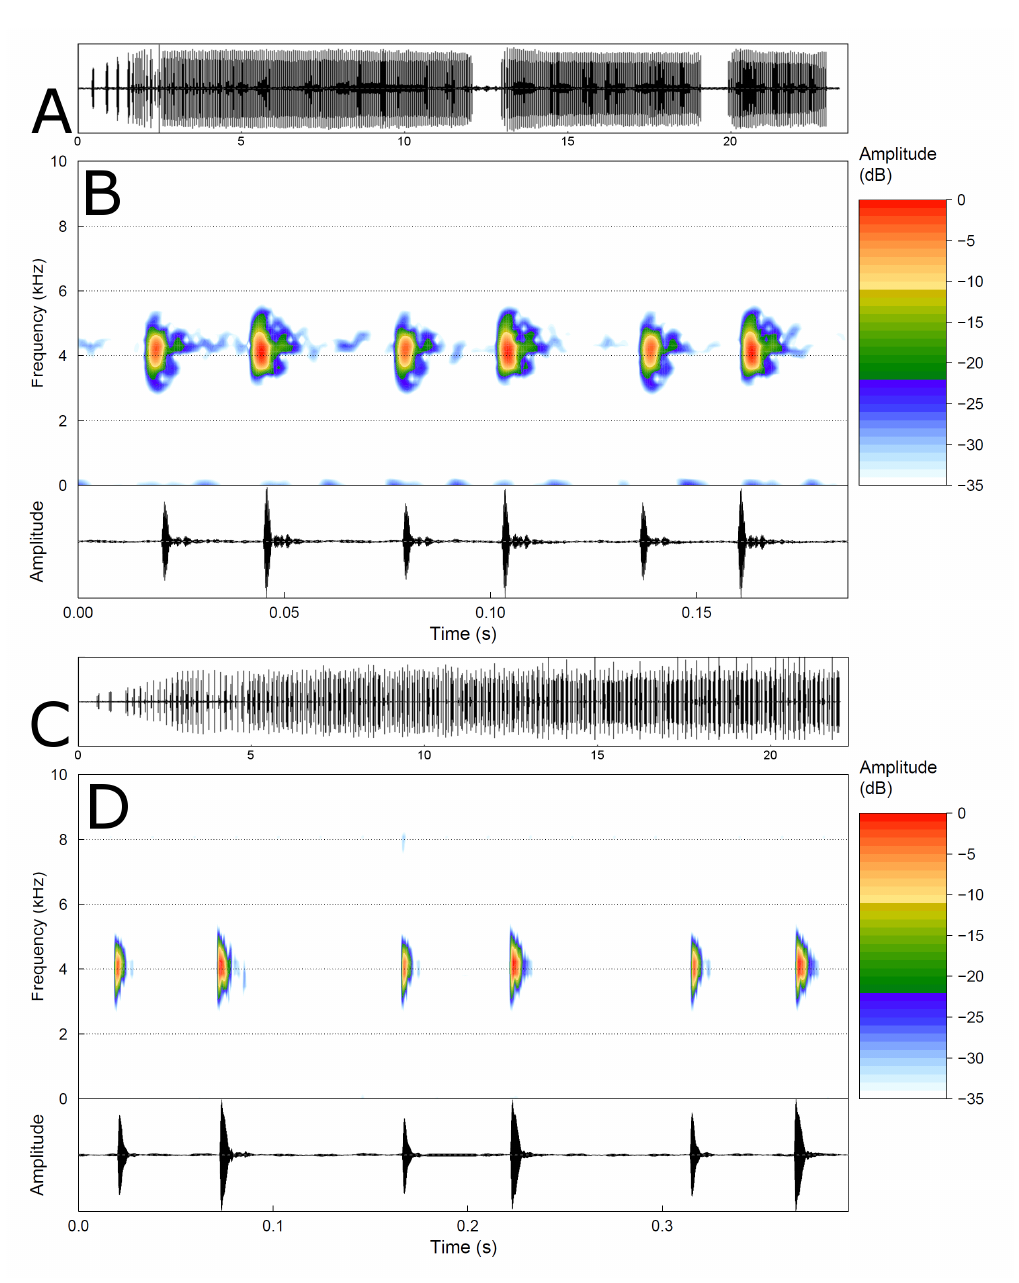
Fig. 4. A . Oscillogram of the entire advertisement call with the introductory notes and three series of two-pulsed notes of Pseudopaludicola matuta sp. nov. B . Audiospectrogram (above) and corresponding oscillogram (below) detailing three two-pulsed notes of the holotype (ZUEC 24302). The holotype was recorded on 29 Nov. 2017 at 19:19 h; air temperature 25.2°C (recording_label: Pseudop_ matutaCurveloMG10iIAH_AAGmt). C . Oscillogram of the entire advertisement call with a single series of two-pulsed notes of P. mineira Lobo, 1994. D . Audiospectrogram (above) and corresponding oscillogram (below) detailing three two-pulsed notes of a topotypical male (ZUEC 24330; GenBank voucher). The topotype was recorded on 4 Dec. 2017 at 19:28 h; air temperature 21.0°C (recording_ label: Psedop_mineiraSantanadoRiachoMG2aIAH_AAGm661MK2). Note the remarkable difference in the time spent emitting the same three two-pulsed notes between these two sister species, P. mineira spends about twice as much time than P. matuta sp.